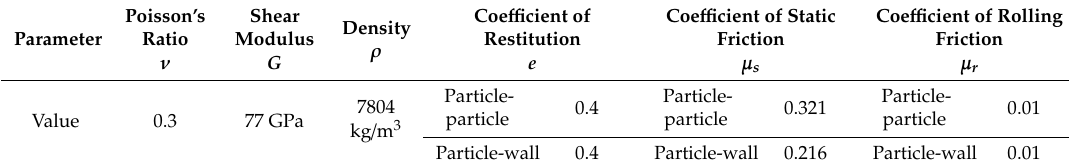
Table 1. DEM input parameters.